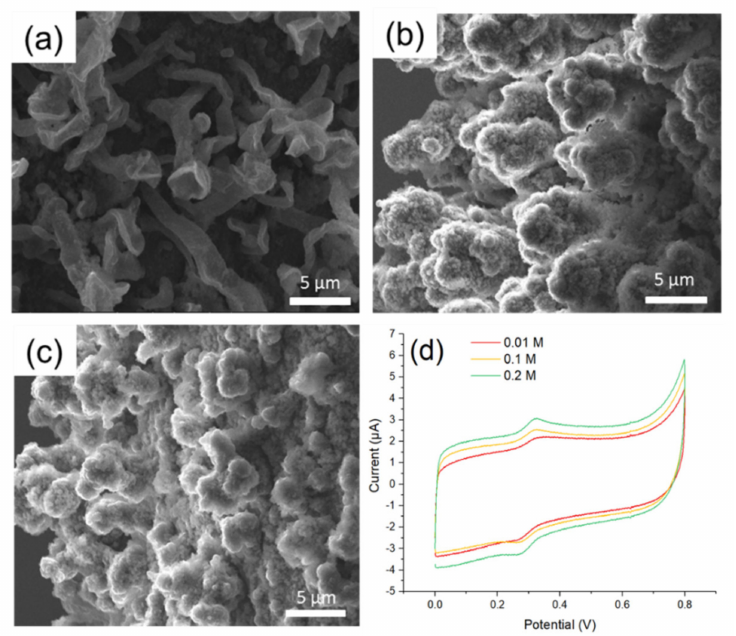
Figure 6. The SEM images of MOF525 / PEM composites synthesized under: ( a ) 0.01 M; ( b ) 0.1 M; and ( c ) 0.2 M TBAP solution; and ( d ) the CV traces of MOF525 / PEM composites modified microelectrode synthesized under various TBAP